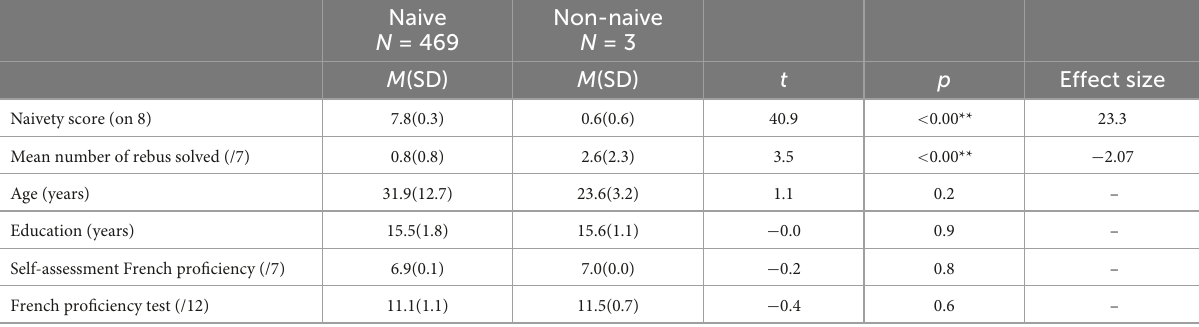
TABLE 8 Mean (M) and standard deviation (SD) of the demographic data for Experiment 2; t - and p -results for the independent sample T-test between naive and non-naive participants; two-tailed p